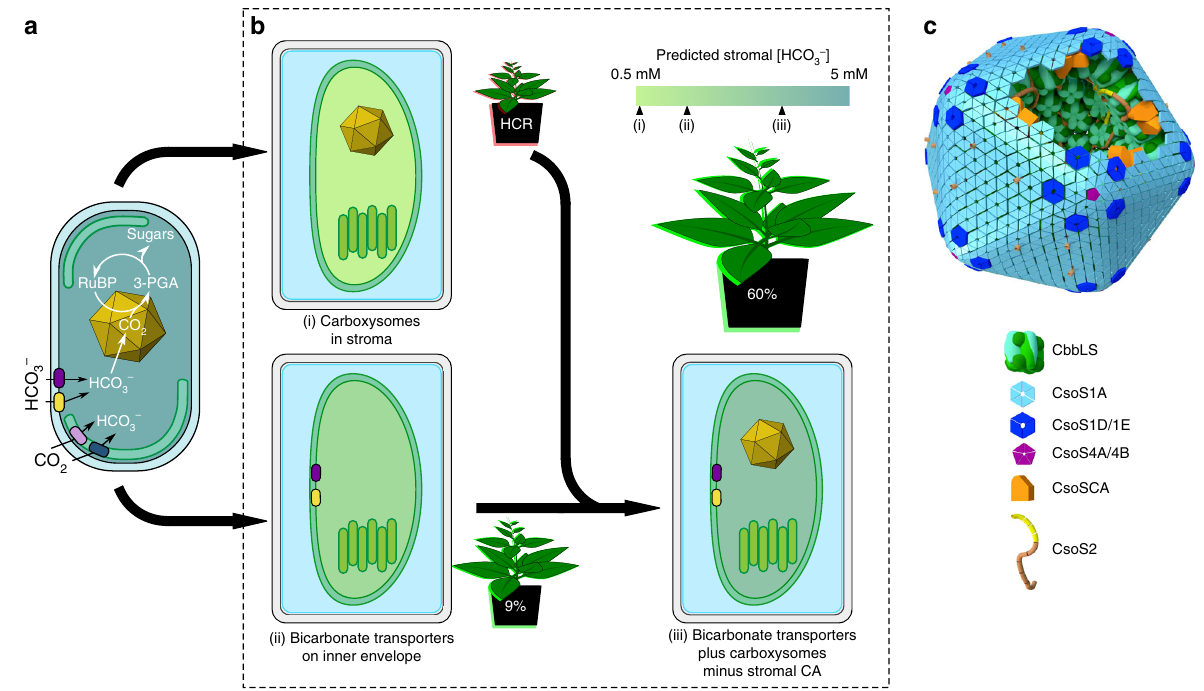
Fig. 1 Cyanobacterial CCM components for improved photosynthesis. Cyanobacterial CCMs ( a ) use bicarbonate (HCO 3 − ) and CO 2 pumps on the plasma and thylakoid membranes, respectively, to elevate cytosolic HCO 3 − . This HCO 3 − pool is utilized by icosahedral-shaped Rubisco microcompartments called carboxysomes (yellow icosahedron), where HCO 3 − is converted to CO 2 by localized carbonic anhydrase (CA) and accumulates due to resistive CO 2 ef fl ux. The carboxysome encapsulates the cell ’ s complement of a high-catalytic-rate Rubisco, which operates at close to V max , converting ribulose-1,5- bisphosphate (RuBP) to 3-phosphoglycerate (3-PGA) within the Calvin cycle. This mechanism leads to ef fi cient photosynthesis and reduced nitrogen allocation compared to C 3 plants. A strategy to improve C 3 photosynthesis in plant cells ( b , represented here as rectangular structures containing dual- membrane chloroplasts) using the cyanobacterial CCM recommends independent transfer of carboxysomes containing their cognate Rubisco to the chloroplast stroma (i) and HCO 3 − pumps (ii) to the chloroplast inner-envelope membrane. Successful transfer of HCO 3 − transporters alone (ii) should generate a moderately elevated stromal HCO 3 − pool (indicated by the change in colour shading of the chloroplast) and has a predicted photosynthetic improvement of 9% 15 due to the resulting net elevation of CO 2 near Rubisco. Expression of functional carboxysomes (i), or just their cognate Rubisco, in the chloroplast stroma should lead to a high CO 2 -requiring (HCR) phenotype due to the characteristically high K M and low speci fi city for CO 2 of carboxysomal Rubiscos and absence of an elevated HCO 3 − or CO 2 pool. However, in combination (iii), generation of high stromal HCO 3 − pool in the